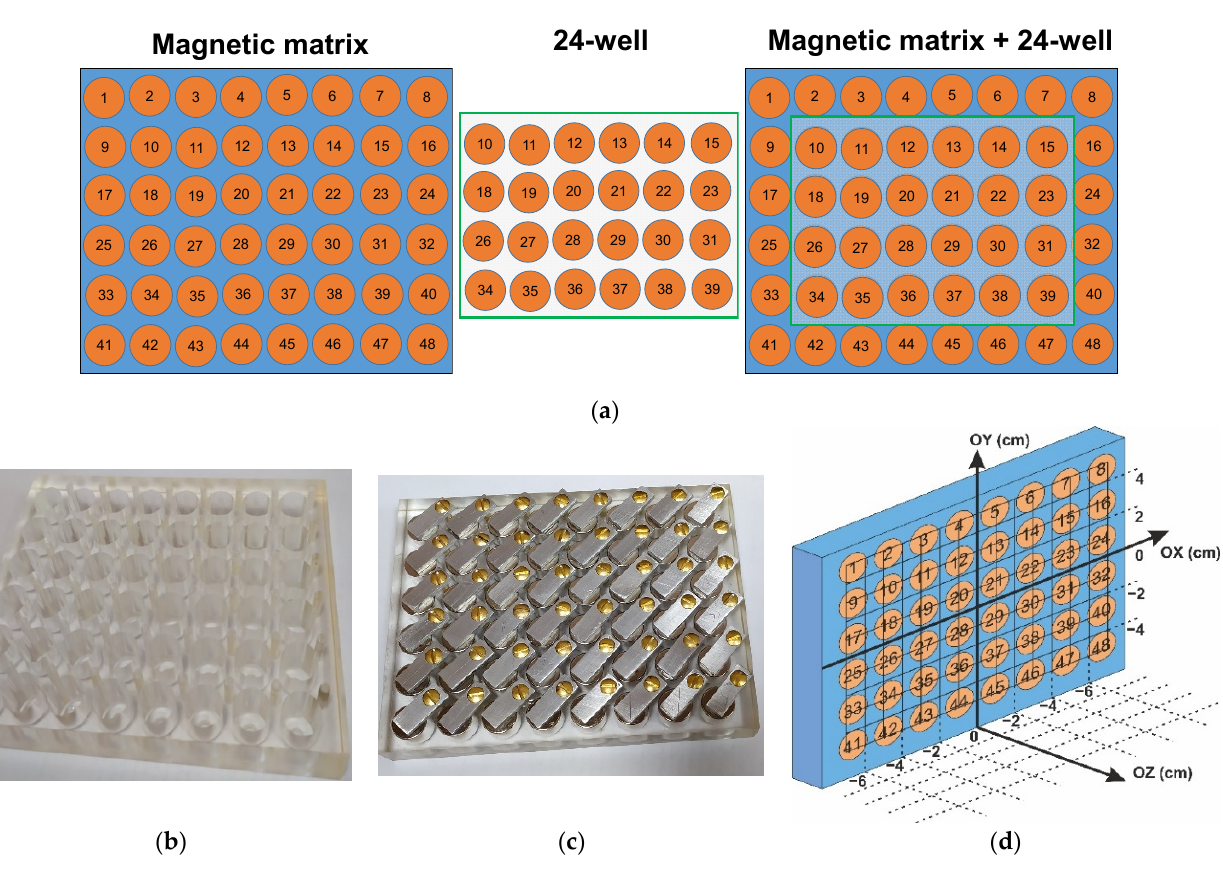
Figure 1. ( a ) Description of the magnetic matrix with 48 positions (left), 24-well plate the same geometry (centre), and 24-well plate on top of magnetic matrix (right); ( b ) polymer frame with selected 48 positions; ( c ) general view of magnetic matrix assembled with the permanent magnets; ( d ) coordinate system for the measurements of the magnetic field of the matrix.